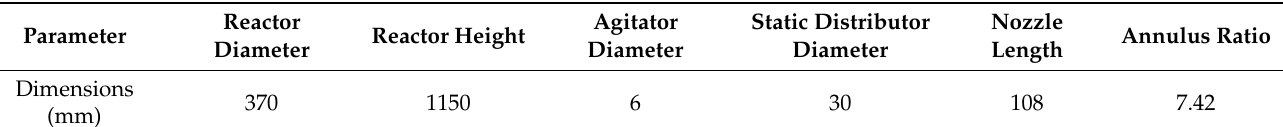
Figure 5. Geometric model of stirred tank Taylor reactor.